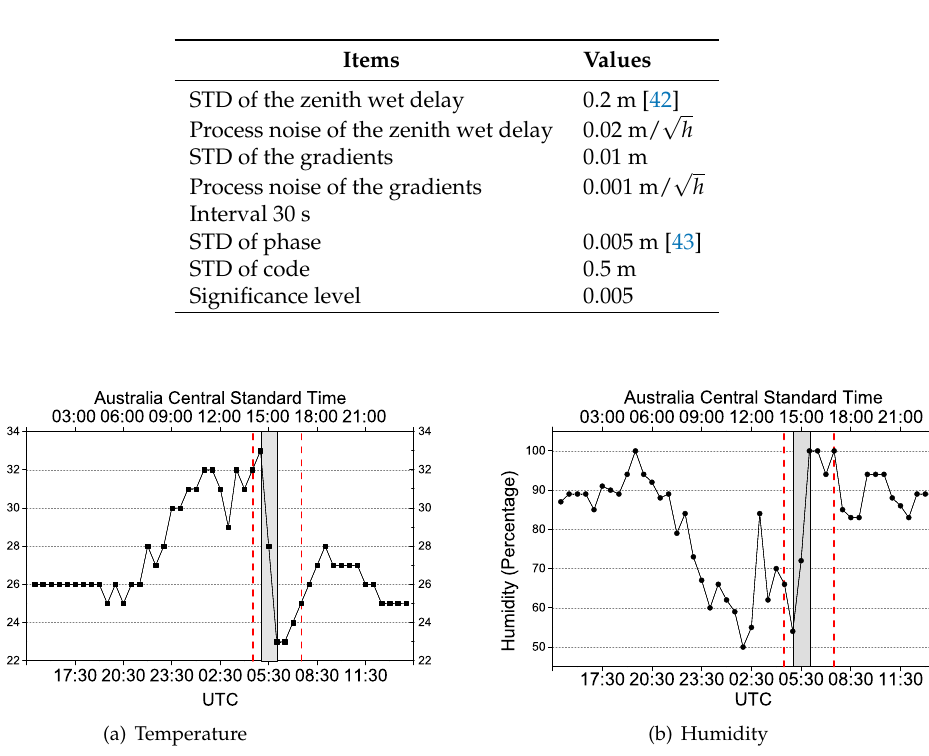
Table 1. Configuration of the data processing for the real-time PPP.